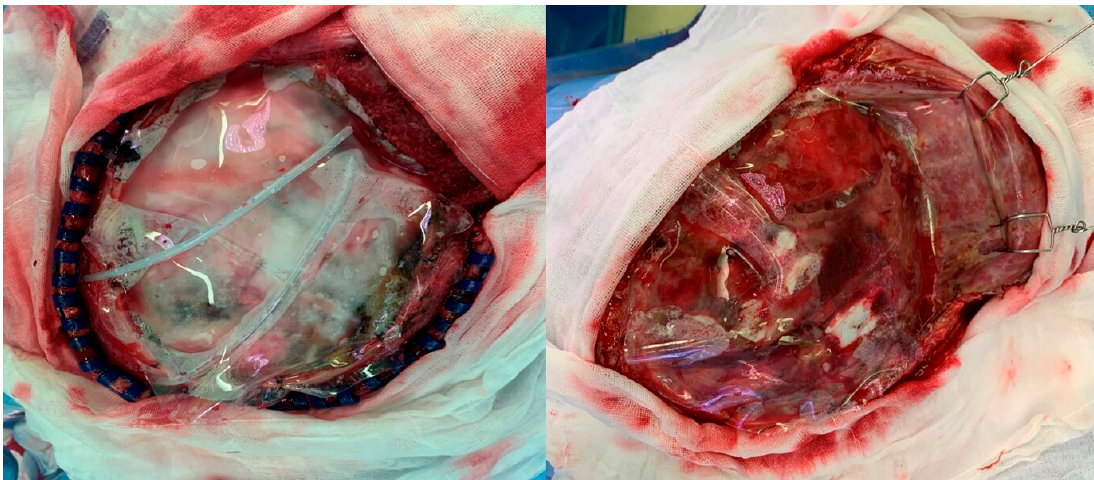
Figure 1. Intraoperative photos. ( A ): After duraplasty, the silicone elastomer sheet cut according to the size of the bone defect was placed on the epidural space and loosely sutured to the bone margin and fixed during decompressive craniectomy. ( B ): Epidural space after dissection on the sheet during cranioplasty .